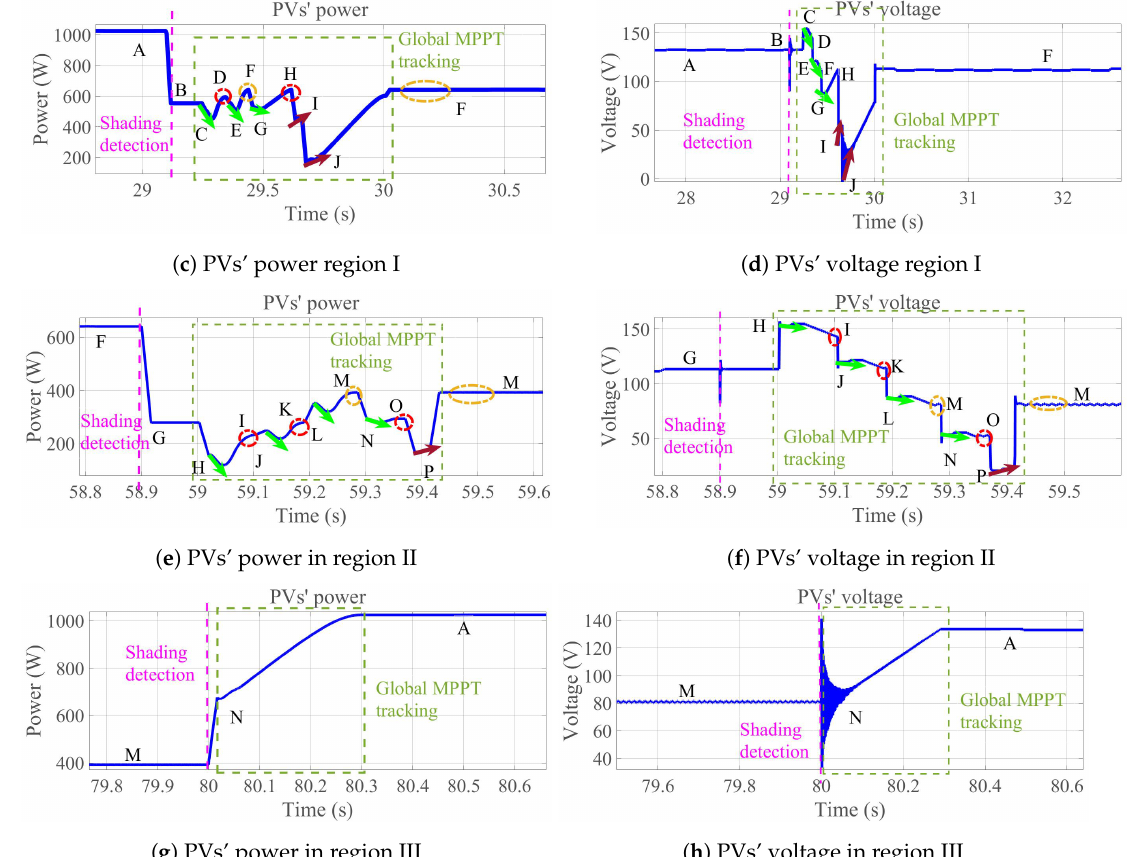
Figure 13. Results from proposed algorithm: ( a ) PVs’ Power tracking result; ( b ) PVs’ Voltage result; ( c , e , g ) Magnified power tracking result for each region; ( d , f , h ) Magnified voltage tracking result for each